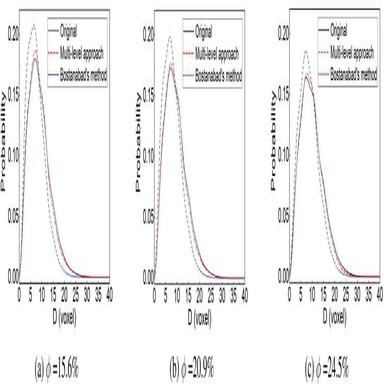
Comparison of PSD P(D) between the original and reconstructed microstructures.